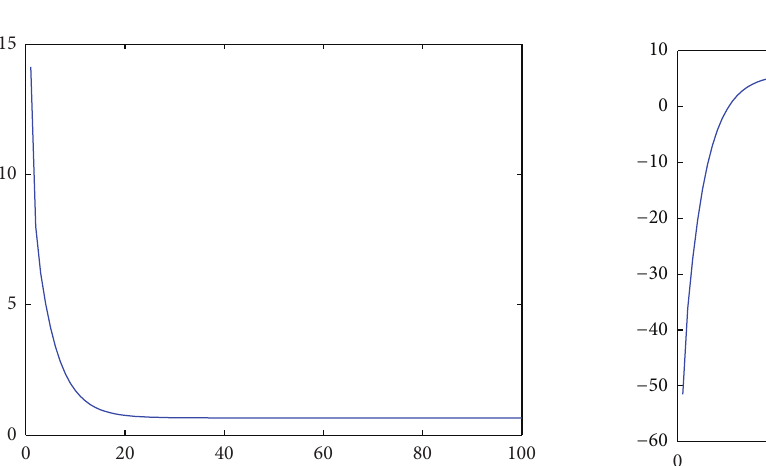
Figure 10: Initial system output trajectory.